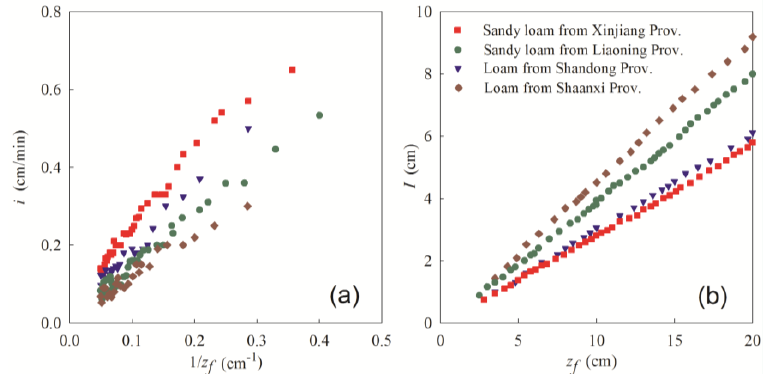
Figure 1. Relationships between i and 1/ z f and between I and z f (the data are the mean values of the three replicates). ( a ) Relationship between i and 1/ z f ; ( b ) Relationship between I and z f .